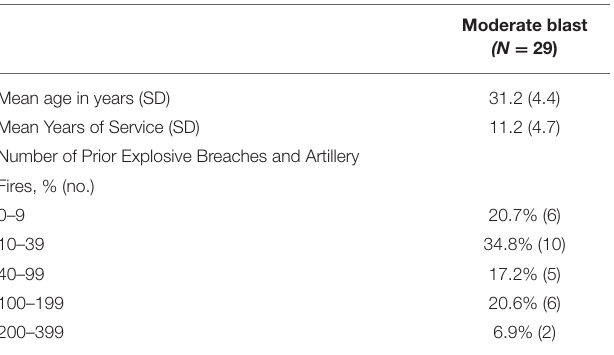
TABLE 1 | Demographic and previous explosive exposure of participants exposed to moderate